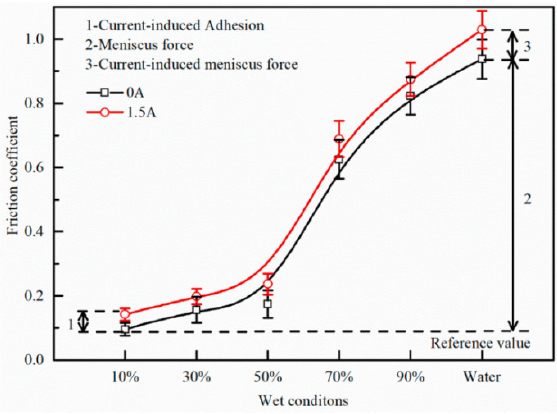
Figure 13. A comparison of the final friction coefficient with and without a current under different wet conditions [92].